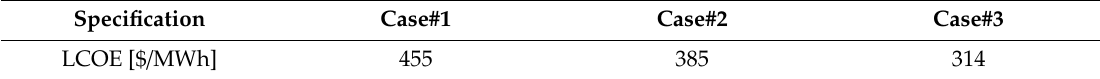
Figure 13. Selected data presenting the Polish electricity market: ( a ) the yearly profile of electricity market price (own illustration based on the data from Polish power exchange TGE SA [49]) and ( b ) cost of electricity generation and weighted average electricity market price. Table 6. Results of economic analysis.